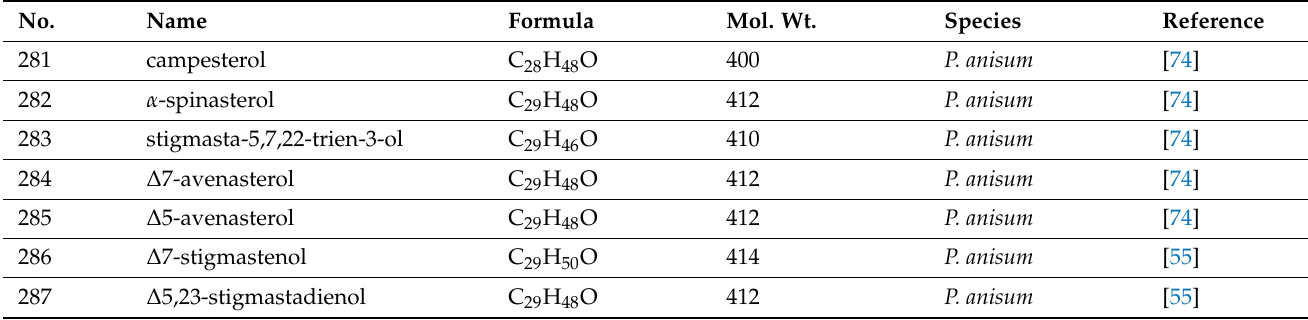
Table 6. Sterols of Pimpinella plants.